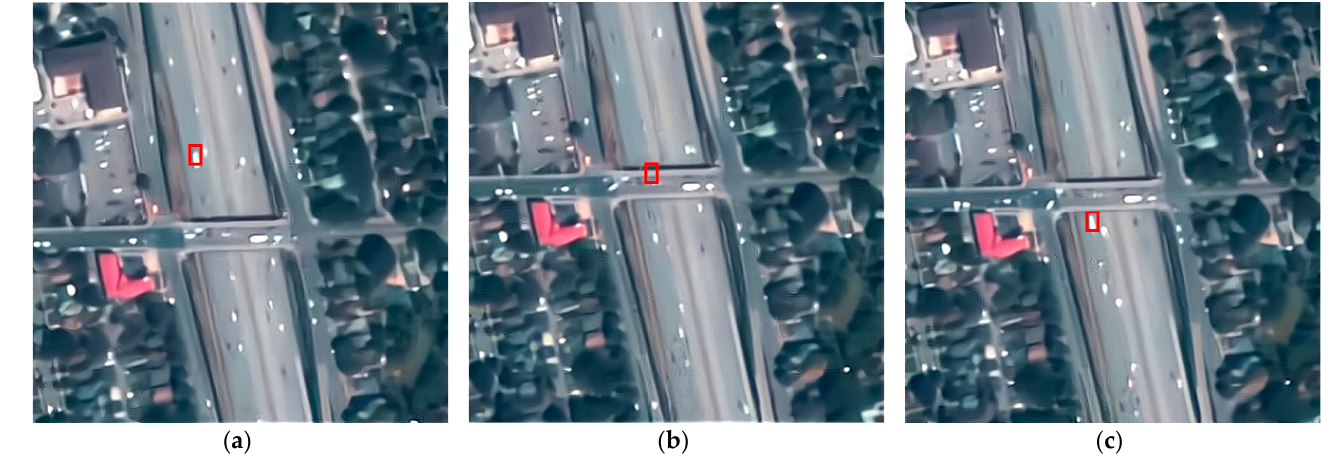
Figure 5. Tracked target is a car. ( a ) Car is running normally. ( b ) Car is occluded by overpass. ( c ) Car reappears after being occluded.